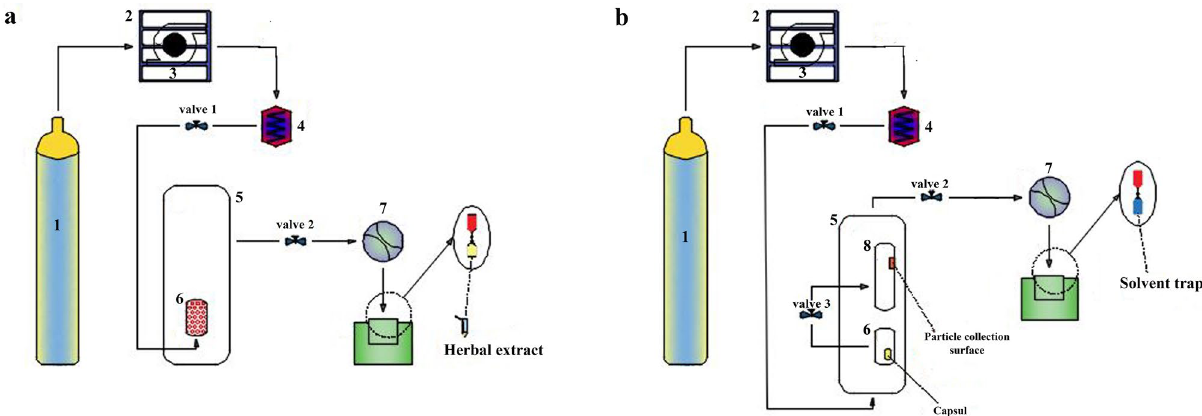
Figure 1. ( a,b ) The schematic diagram of the SFE and ESS set up: (1) CO 2 cylinder, (2) chiller, (3) high-pressure syringe pump unit, (4) heat exchanger, (5) oven, (6) extraction/equilibration vessel, (7) restrictor, (8) collection